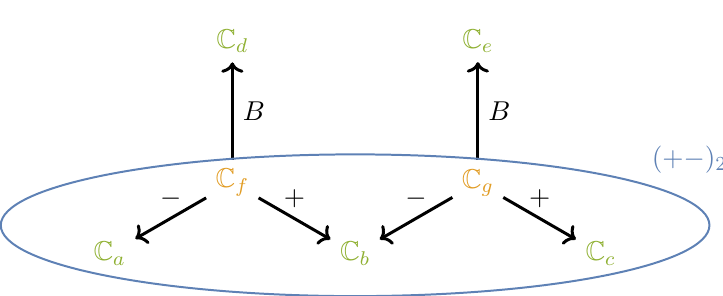
Figure 37. A tree module for a dimension (2 ; 5) representation.